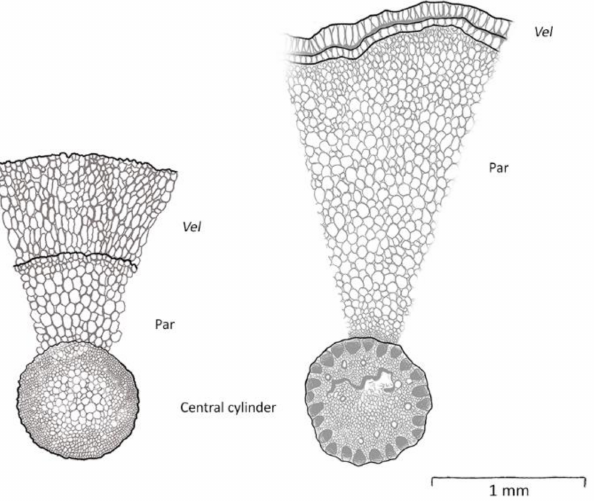
Figure 4. Schematic view of two crosscuts of velamentous roots, Myrmecophila tibicins (Orchidaceae) on the left and Anthurium paludosum (Araceae) on the right. Central cylinder, parenchyma (Par), and velamen radicum ( Vel ) are